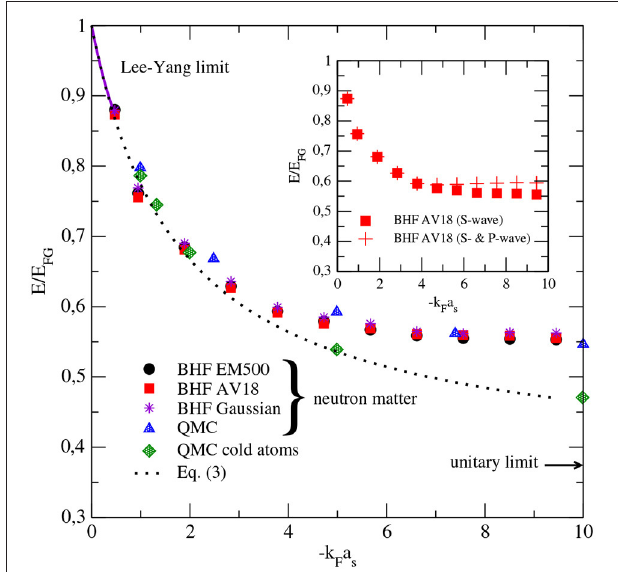
FIGURE 1 | Ground state energy (in units of E FG ) of low-density neutron matter as a function of the dimensionless parameter − k F a s . Results are shown for our BHF calculation (full circles, full squares and stars) and the QMC one (full triangles) of reference [ 27]. The energy of cold atoms (full diamonds), obtained also by the authors of reference [27], is shown for comparison. The continuous line displays the Lee–Yang limit (see Equation 3) for − k F a s ≪ 1 [68]. The arrow indicates the most precise experimental value ξ = 0.376(4) [ 39] of the Bertsch parameter measured with ultra-cold atomic gases at the unitary limit. The dotted line shows the density functional proposed by Lacroix (see Equation 4) in reference [ 69]. The inset shows, as illustration, the effect on the ground state energy of the inclusion of the 3 P 0 , 3 P 1 , and 3 P 2 partial waves in the case of the BHF calculation with the AV18